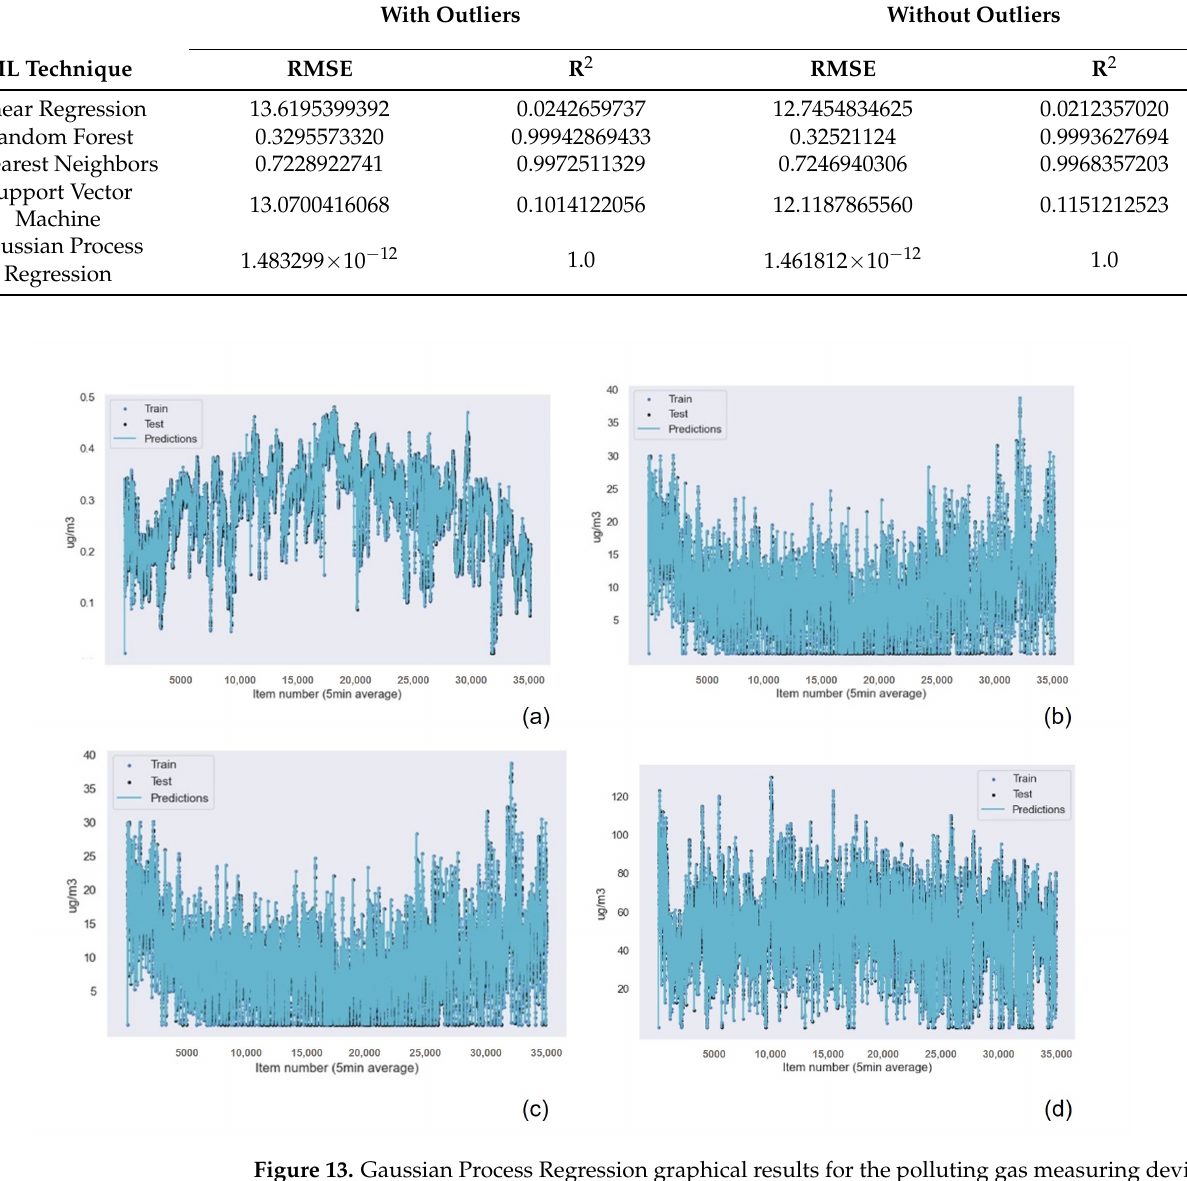
Figure 13. Gaussian Process Regression graphical results for the polluting gas measuring device of ( a ) the CO sensor data, ( b ) the NO 2 data with outliers, ( c ) the NO 2 data without outliers, and ( d ) the O 3 data with